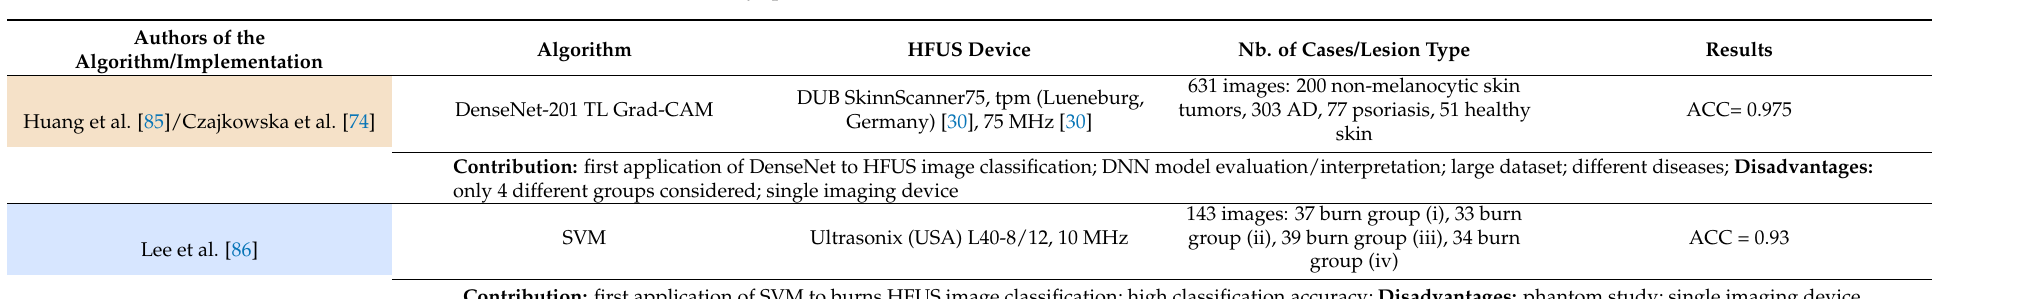
Table 9. Skin lesion classification summary (part